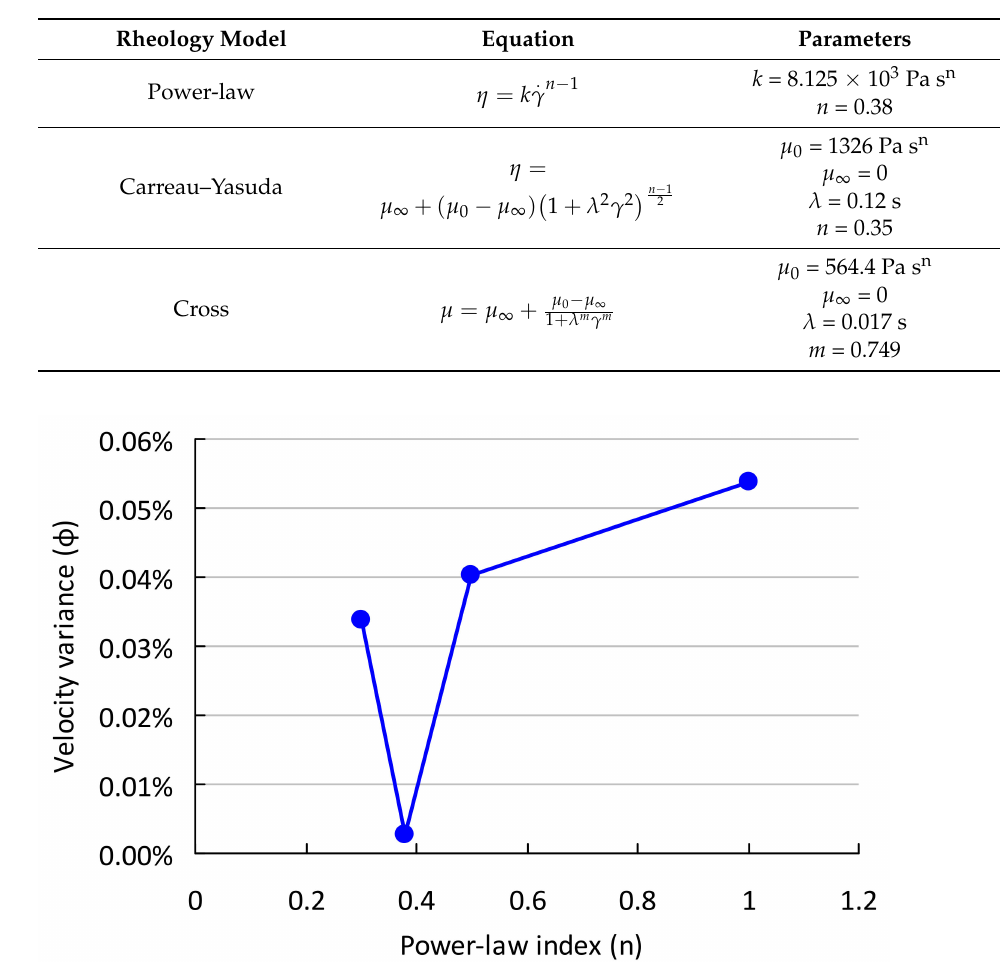
Figure 4. Sensitivity analysis of the model for a power-law fluid ( Q 0 of 5 × 10 − 5 m 3 /s, h s of 1.5 mm and b of 360